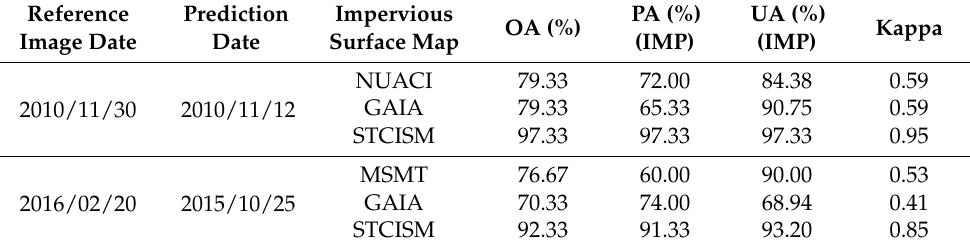
Table 2. Accuracy of the four impervious surface maps: Normalized Urban Areas Composite